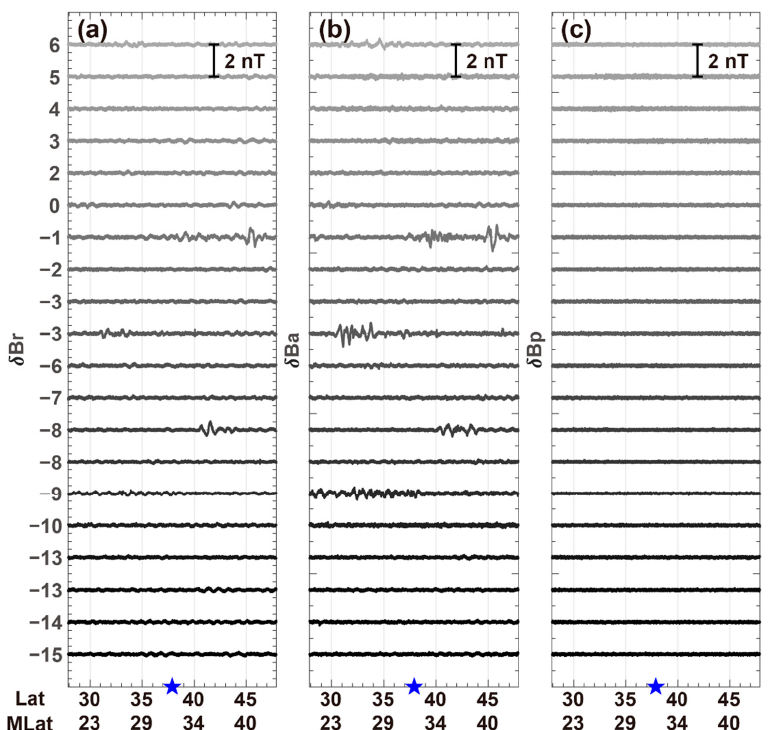
Figure 8. Magnetic disturbances observed by Swarm B 15 days before and 7 days after the M7.0 earthquake and in the range of 10° latitude by 10° longitude centered on an M7.0 epicenter. Panels ( a – c ) show the residual magnetic field in radial, azimuthal and parallel directions. Blue stars on x -axes represent the epicenter’s latitude. y -axis indicates time-differences ( Δ T in days) between Swarm observations and the earthquake time.